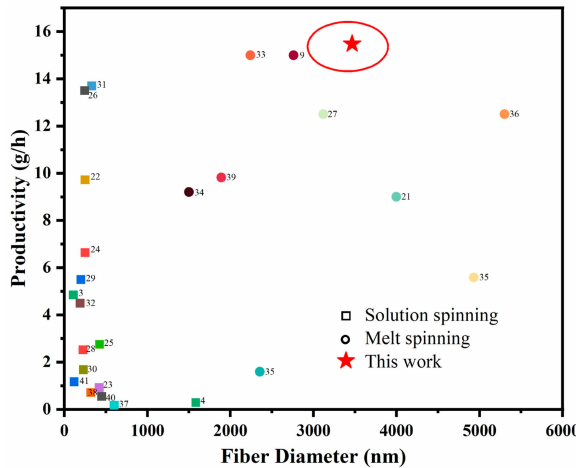
Figure 6. Comparison graph of fiber injection efficiency for different methods [3,4,15–35].